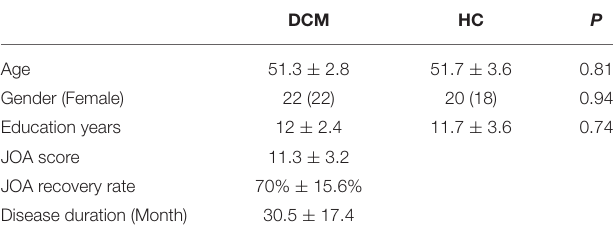
TABLE 1 | Demographic